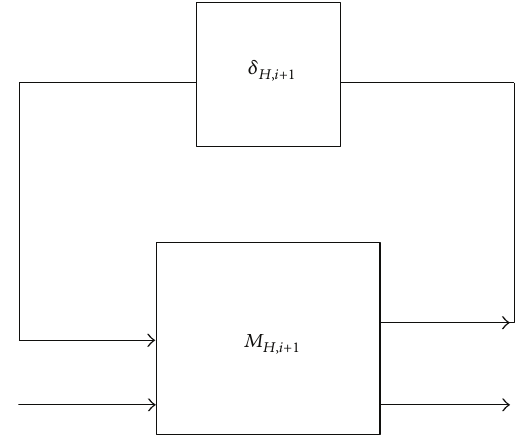
Figure 4: Representation of uncertain parameter ( 𝐻 𝑖+1 ) as